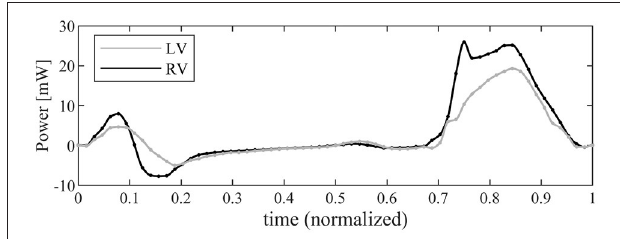
FIGURE 7 | Graphical representation of the instantaneous power associated with blood flow for left ventricle (LV) (gray line) and right ventricle (RV) (black).